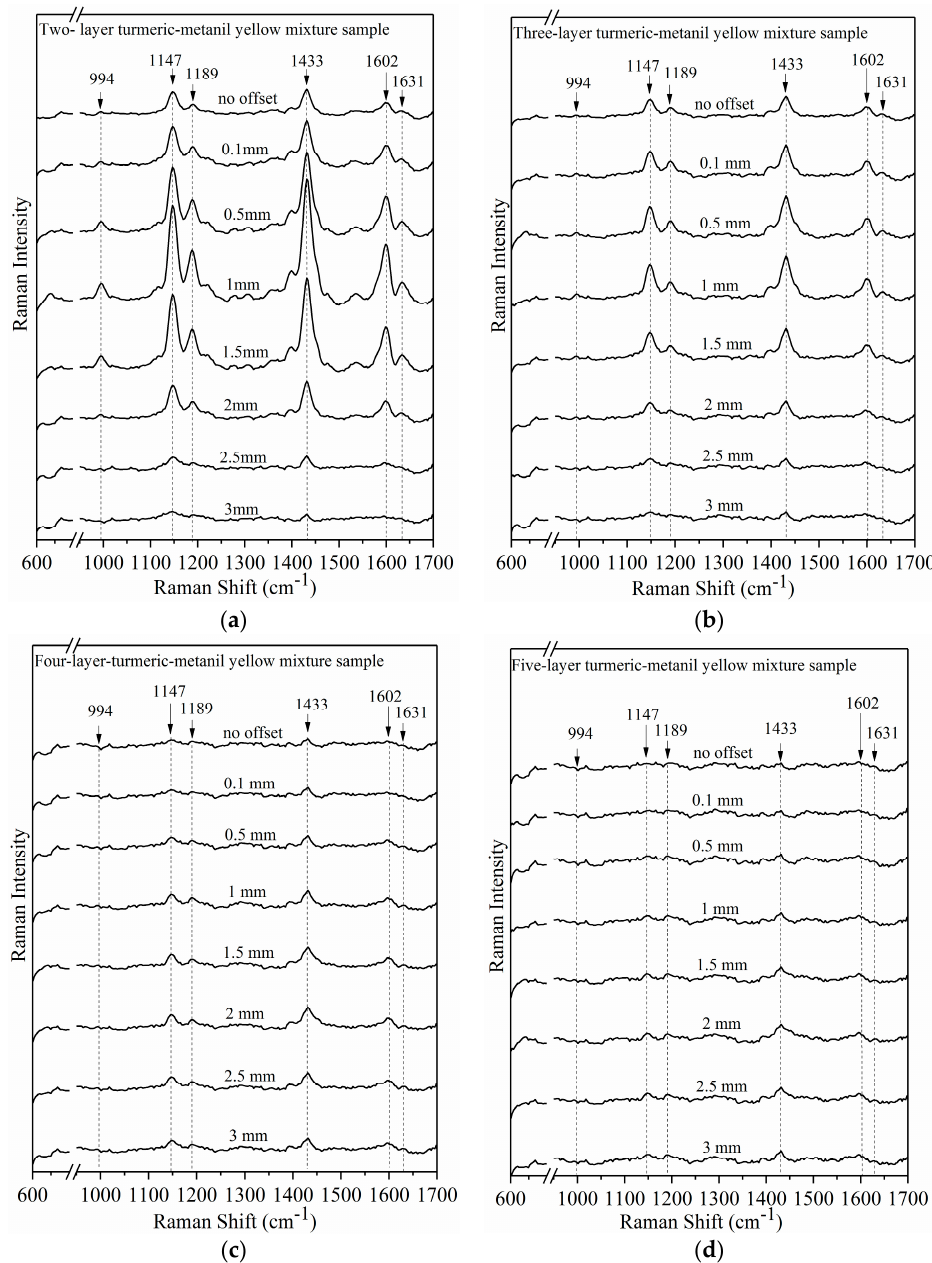
Figure 12. Spatially offset Raman spectra of turmeric-metanil yellow mixture packaged inside: two-layer ( a ); three-layer ( b ); four-layer ( c ); and, five-layer ( d ) capsule.